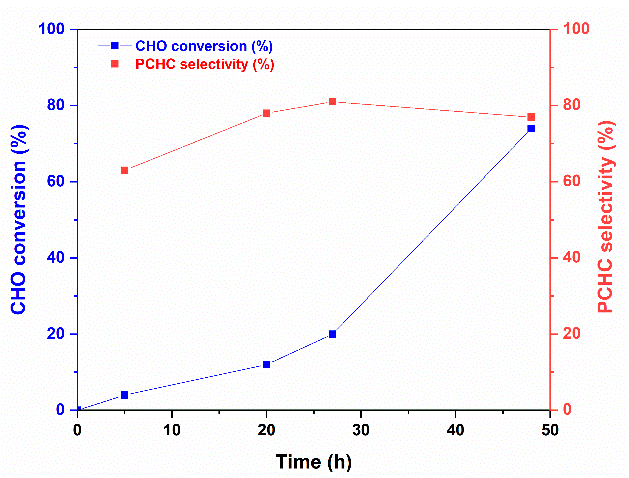
Figure 3. PCHC selectivity in the ROCOP of CHO with CO 2 catalysed by 1 using BnOH initiator (reaction conditions of entries 10 – 13 of Table 2).